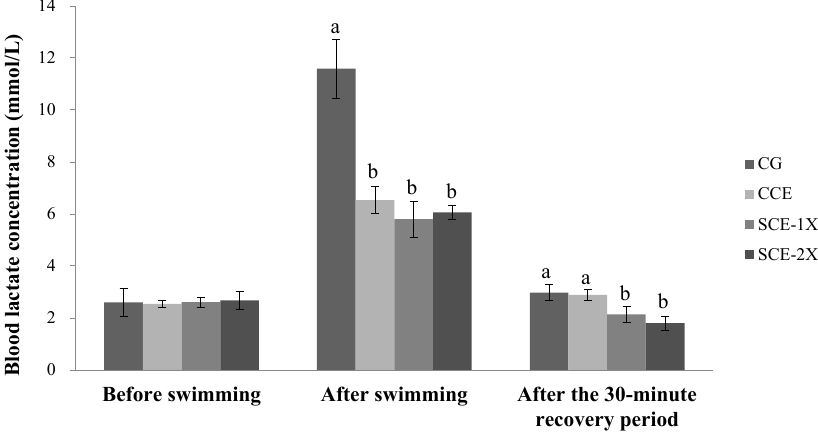
Figure 3. The effect of different treatments on the blood lactate concentration in mice. Values are means±standard deviation for n = 8 mice per group. CG, control group; CCE, commercial dripped chicken essence; SCE-1X, spent hen dripped chicken essence; SCE-2X, double dosage of spent hen dripped chicken essence. a,b Bars with different letters are significantly different at p<0.05.